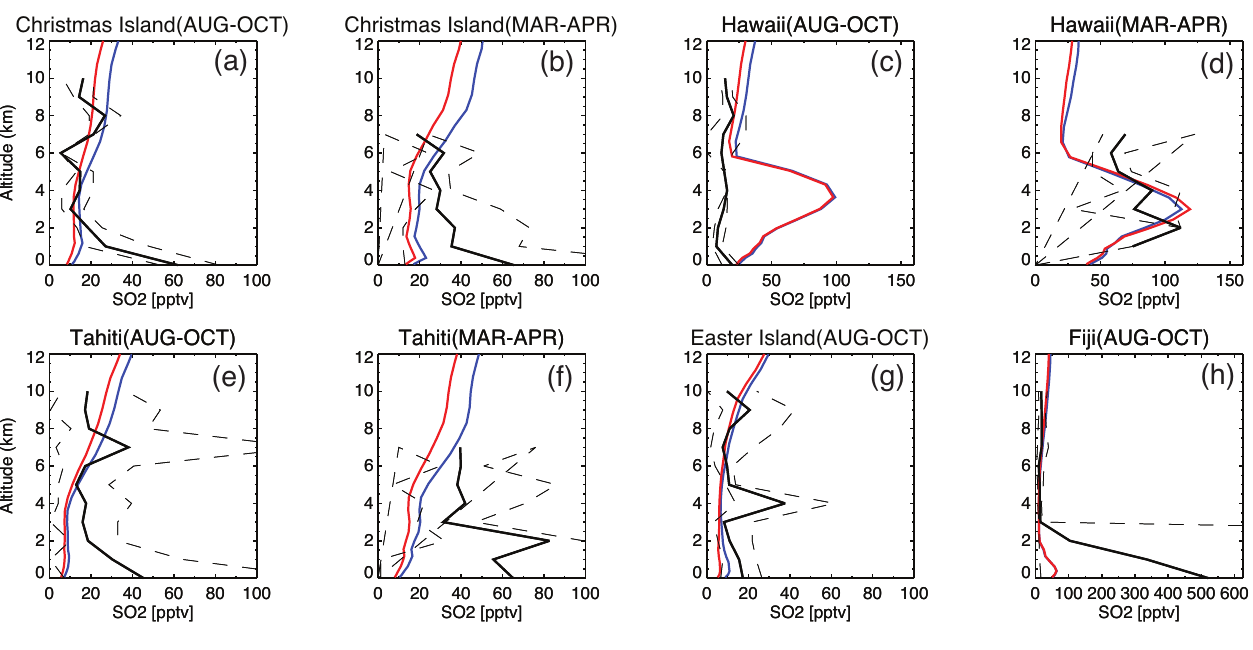
mons et al., 2000). Model outputs are averaged over the ob- servational time period and domain. Simulated DMS vertical profiles are very similar between the two aerosol models, al- though the surface DMS is different as their emissions are not the same. Both models show good agreement with the observations (mostly within the 25th and 75th percentiles of observed values), especially capturing a strong concentration decrease from the surface to the free troposphere. In the case of SO 2 , even though the agreement is not as good as that seen for DMS, both aerosol models seem to cap- ture the observed magnitude approximately within a factor of 2 (see Fig. 5). The overall vertical patterns shown in the mod- els are frequently not in agreement with the observations.